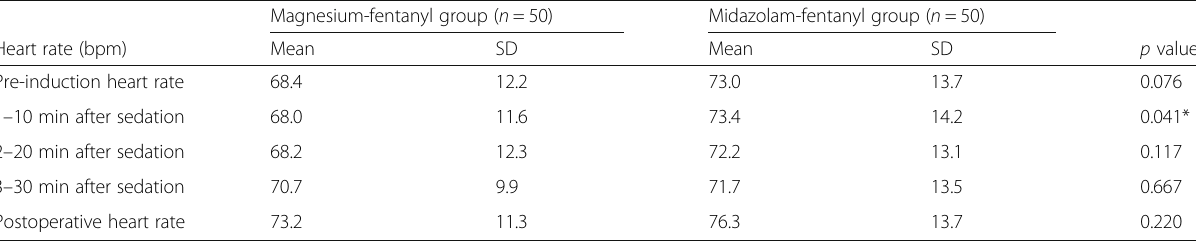
Table 2 Heart rate changes in both study